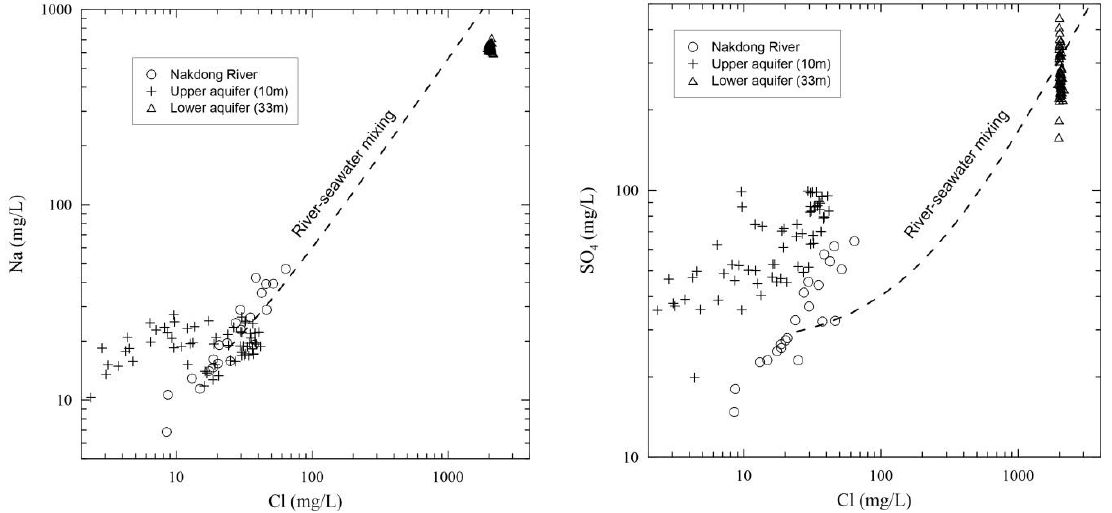
Figure 8. Major ions and Cl concentrations of the Nakdong River and groundwater in the upper and lower aquifers.